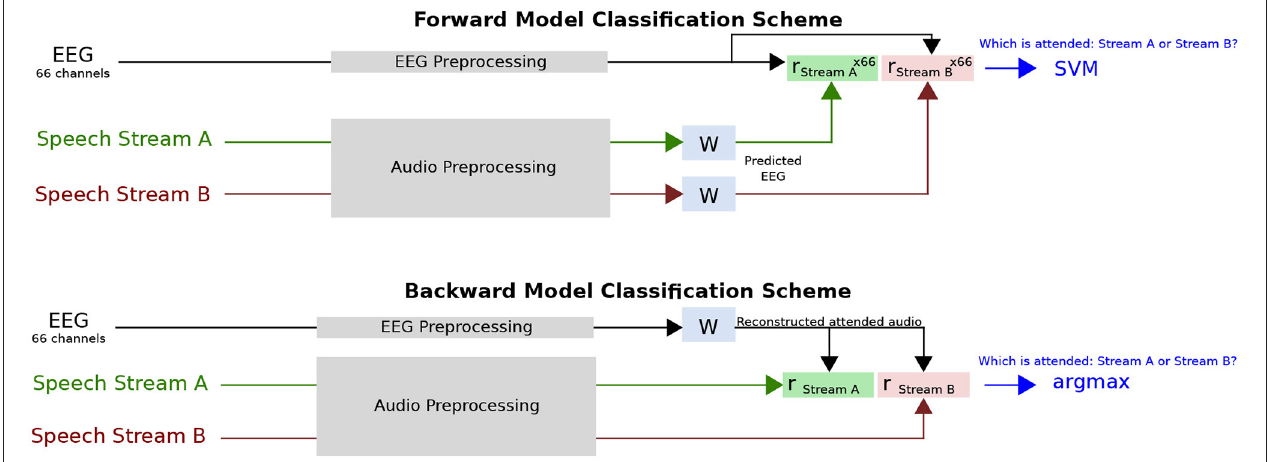
FIGURE 1 | Diagram of classification task. For the forward model, 66 EEG channels are predicted from the speech stream A and B envelopes using the same linear mapping function, W. After correlation with the 66 channel EEG data, this results in 66 correlation coefficients for each speech stream, which are used as features for the SVM to distinguish the attended talker. For the backward model, a single attended audio envelope channel is estimated from the EEG data using the linear mapping function, W. After correlation with the speech stream A and B envelopes, a single correlation coefficient for each speech stream is obtained. Classification of the attended talker is performed by determining the larger